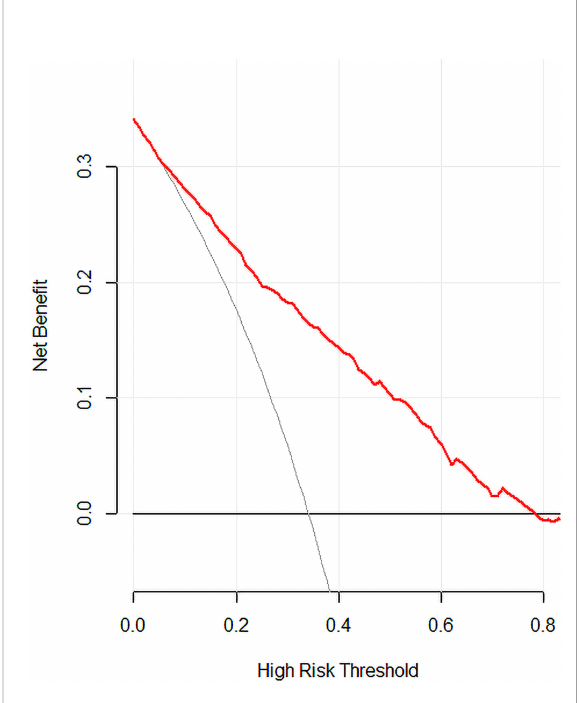
FIGURE 3 Decision curve analysis for the model. The y-axis measures the net bene fi t. The x-axis represents the threshold probability. The red solid line represents the nomogram. The gray line represents the hypothesis that all patients had LN-level II metastasis. The black solid line represents the hypothesis that none of the patients had LN-level II metastasis. The decision curve indicates that when the threshold probability is >10.0%, use of this predictive model would accrue greater bene fi t than that accruing from a treat-all or treat-none strategy.